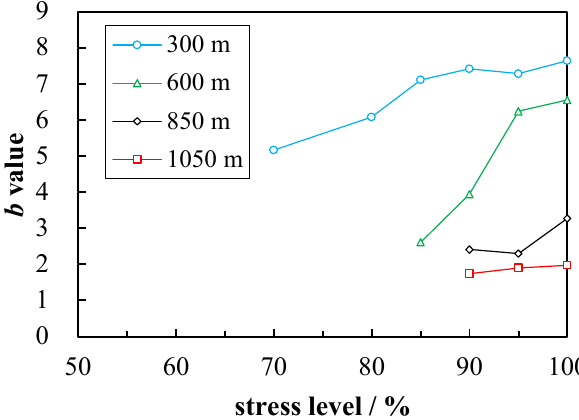
Figure 7. Variation in the b value of coal samples at different depths with respect to the axial stress level.